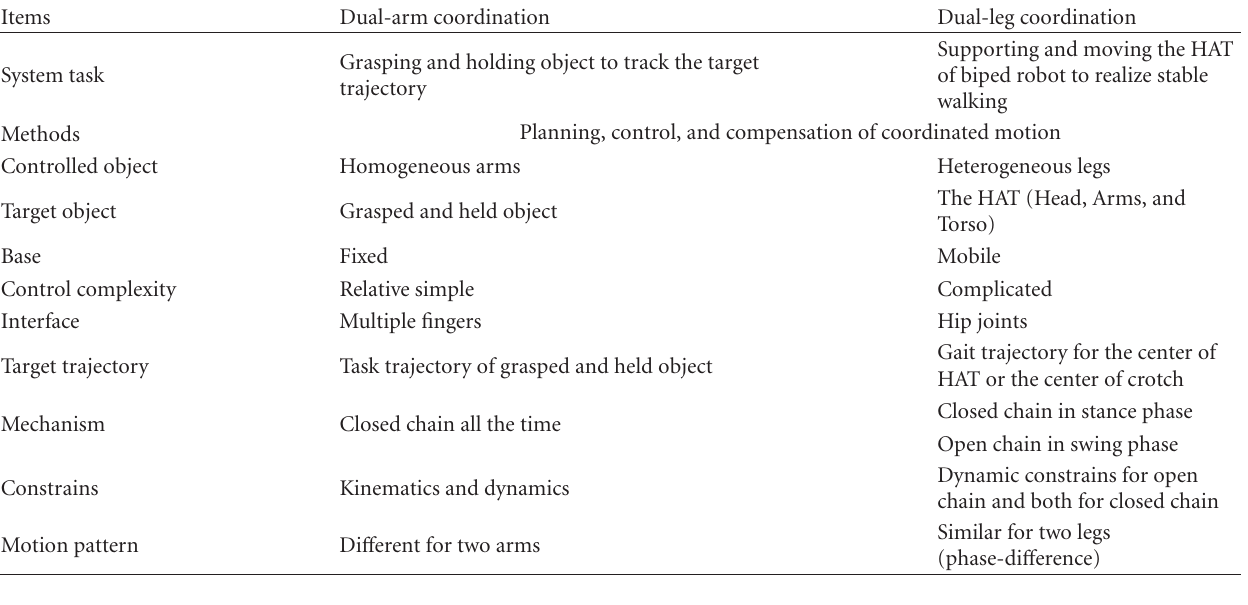
Table 1: Comparison between dual-arm and dual-leg coordination.